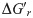
Computed pathways for glycolysis: r1, r2, r3, r4, r5, r6 and r7.Round rectangles represent compound nodes, rectangles represent reaction edges, and the data in parentheses denote the value ΔG′r of reaction and compound similarity respectively. “*” means that the Gibbs free energy of the corresponding reaction is not available.